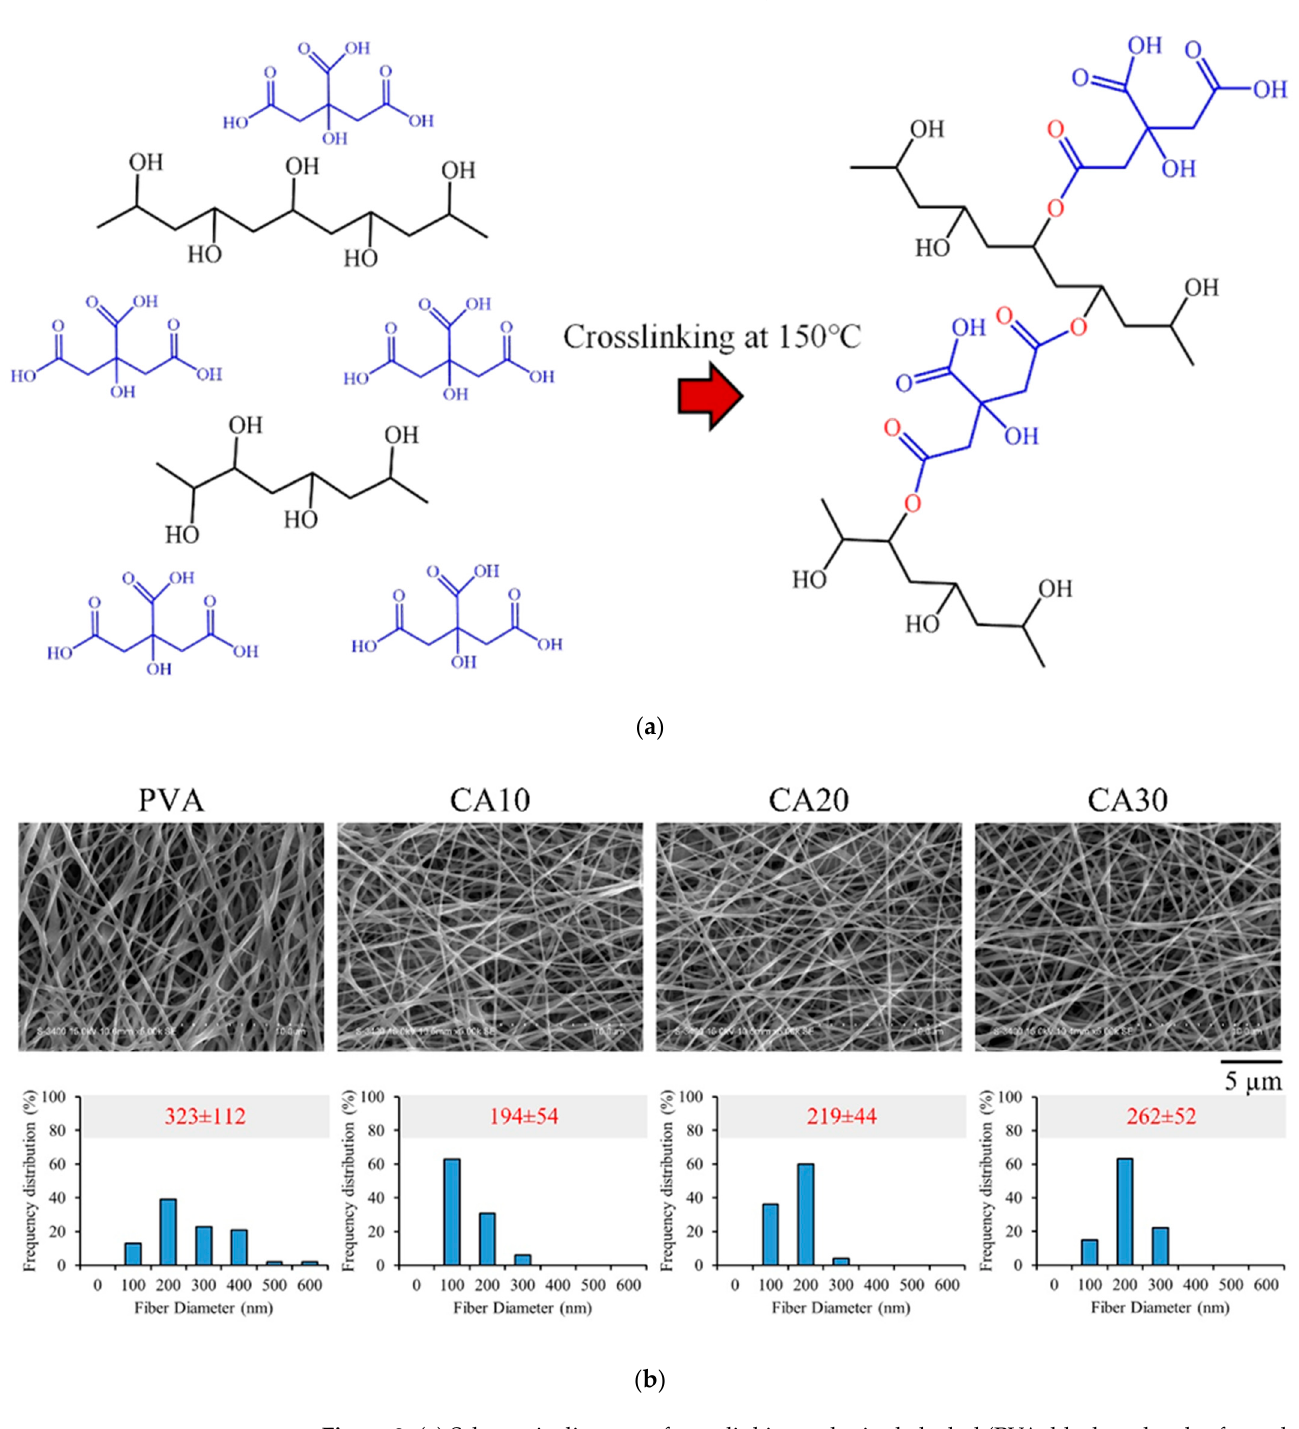
Figure 2. ( a ) Schematic diagram of crosslinking polyvinyl alcohol (PVA, black molecular formula) with citric acid (CA, blue molecular formula). ( b ) SEM images of PVA membranes without crosslinking and crosslinked with CA of di ff erent concentrations (magnitude: 5000×).